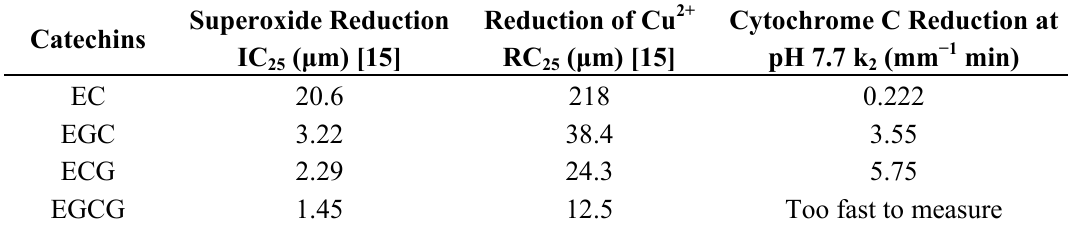
Table 1. A comparison of the relative reactivities of green tea catechins towards different oxidizing